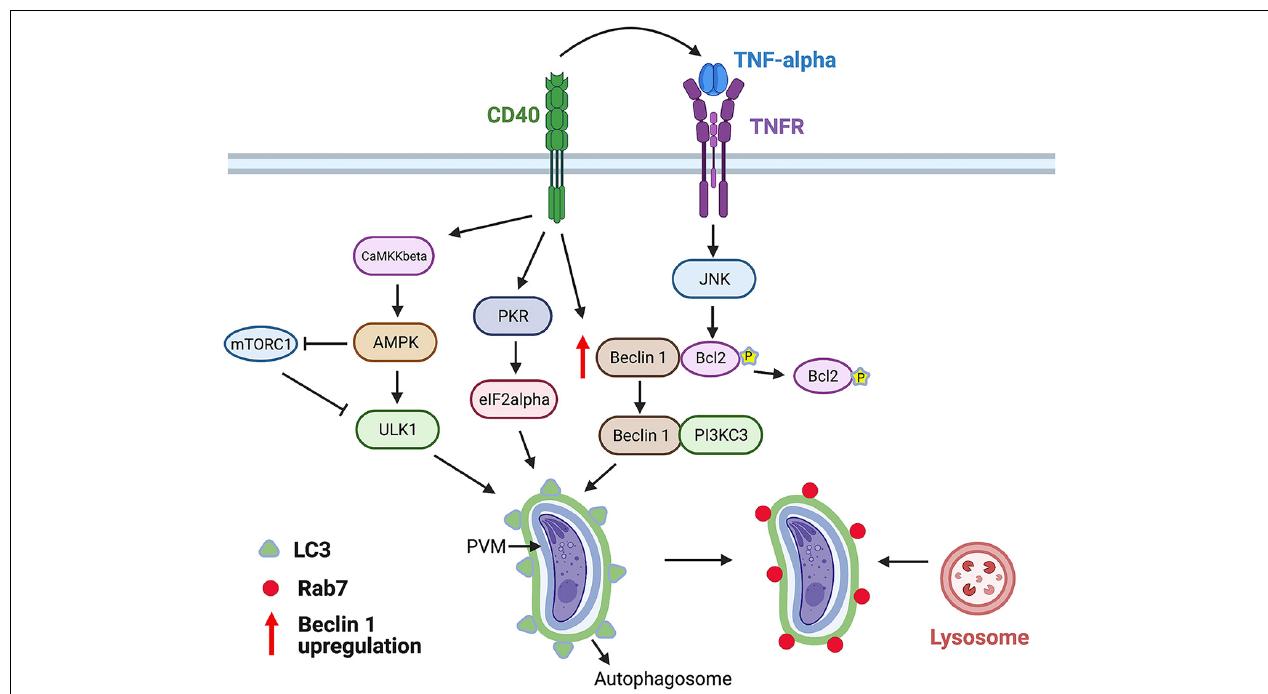
FIGURE 2 | CD40 induces killing of T. gondii via autophagy. CD40 ligation stimulates autophagy by activating ULK1, upstream kinase in the autophagy pathway. This process is dependent on calcium sensor CaMKK β that activates energy/nutrient sensor AMPK. Besides activating ULK1, AMPK inhibits mTORC1, an inhibitor of autophagy. In addition, CD40 stimulates autophagy by triggering activation of pro-autophagy proteins PKR and eIF2 α , upregulating autophagy protein Beclin 1, and releasing Beclin 1 from its negative regulator Bcl-2 after Bcl-2 phosphorylation induced by TNF receptor (TNFR)-JNK signaling. CD40 induces recruitment of LC3 around parasitophorous vacuole membrane (PVM) followed by Rab7-dependent fusion with lysosomes and killing of parasite. This process requires ULK1, Beclin 1, PI3KC3, ATG5, ATG7, and lysosomal enzymes. Figure was generated using